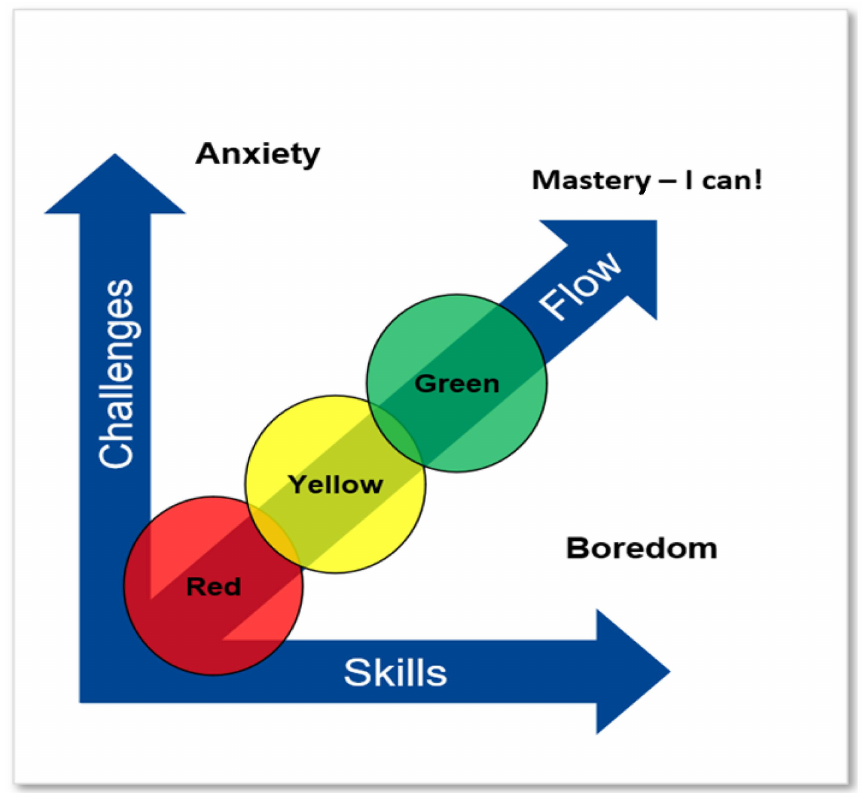
Figure 1. READ approach. The relation between challenges and skills in the READ approach. From the simple to the